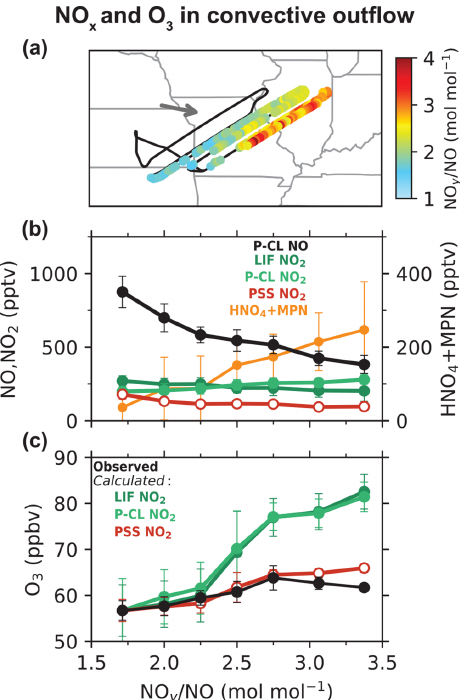
Figure 2. Evolution of NO x and O 3 concentrations in a thunder- storm outflow targeted for quasi-Lagrangian sampling by DC3 flight 17 over the central U.S. at 12km altitude. Panel (a) shows the flight track with data points within the outflow colored by the observed NO y / NO ratio as a measure of chemical aging. The arrow shows the mean wind direction. Panel (b) shows the measured concentra- tions of NO, NO 2 , and the sum of HNO 4 and MPN as a function of the NO y / NO molar ratio. Also shown are the PSS NO 2 concentra- tions (Eq. 3). Panel (c) shows the measured ozone concentrations as a function of the NO y / NO molar ratio along with the ozone con- centrations calculated from Eq. (4), with NO 2 concentrations from LIF, P-CL, or PSS NO 2 . The circles and the error bars in panels (b) and (c) show the means and standard deviations for each NO y / NO